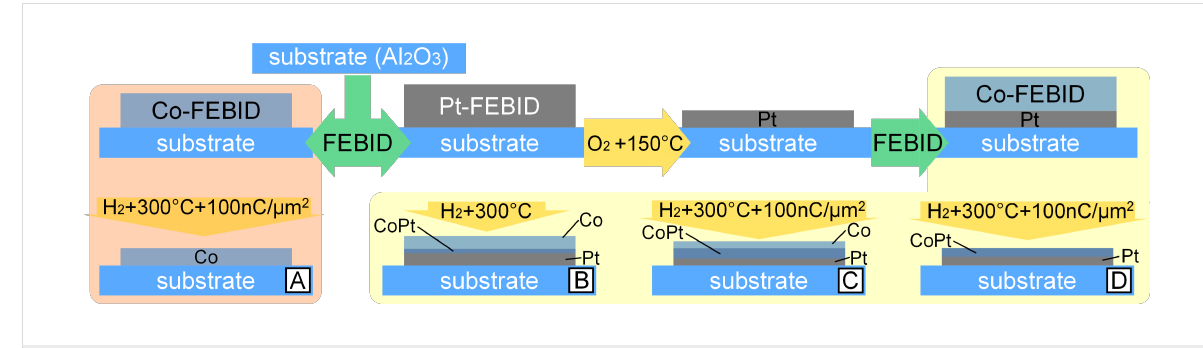
Figure 1: Preparation and post-processing of the samples investigated in this work. Throughout the text the samples are referred to by their labels A, B, C, and D, as indicated.